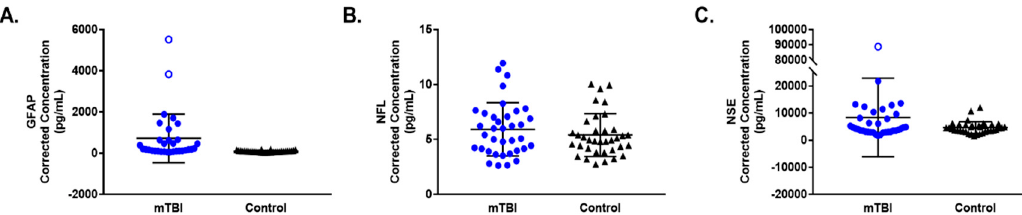
Figure 5. Scatterplots depicting the corrected concentrations of blood-based biomarkers ( A ) GFAP, ( B ) NFL and ( C ) NSE measured from blood samples obtained upon patient presentation to the ED. Mean and standard deviation are shown for individuals who sustained a mTBI (mTBI) and healthy controls (control) for all biomarkers assessed. Outliers are denoted by empty circles (mTBI), which were excluded from OR analyses presented in Table